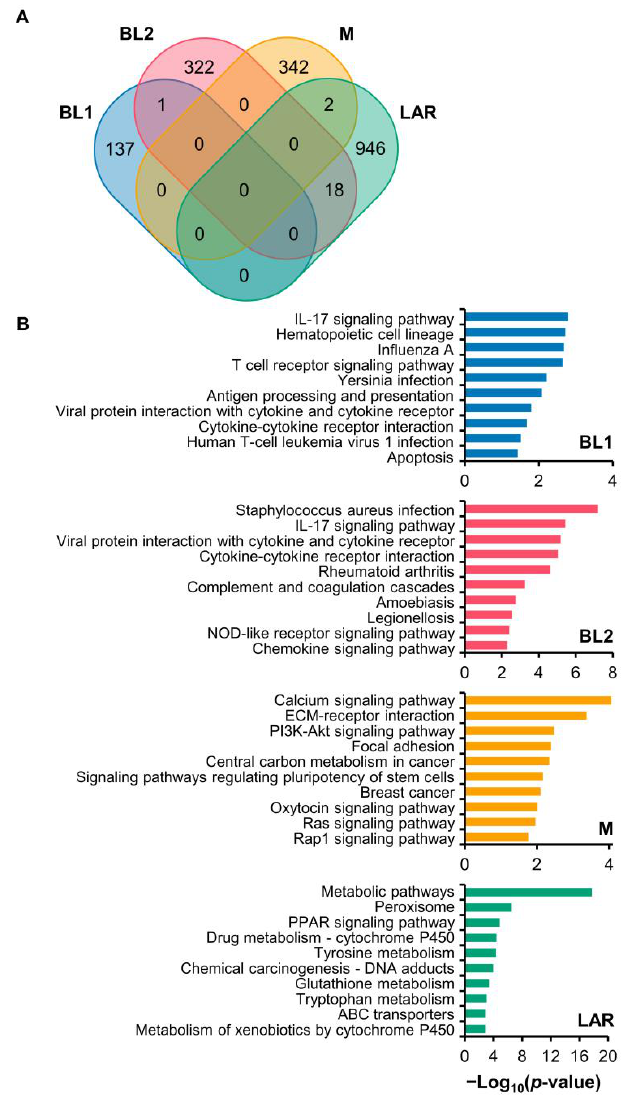
Figure 4. Gene expression and KEGG pathway enrichment analysis of four TNBC subtypes. ( A ) Venn diagram of the DE genes in the four subgroups of TNBC. Upregulated DE genes of the individual TNBC subtypes included BL1 (137 genes), BL2 (322 genes), M (342 genes), and LAR (946 genes) with minimal overlapping between subtypes. ( B ) KEGG pathway analysis enriched in upregulated genes of specific subtypes. The top ten enriched pathways were displayed with the minus of Log 10 ( p -value).